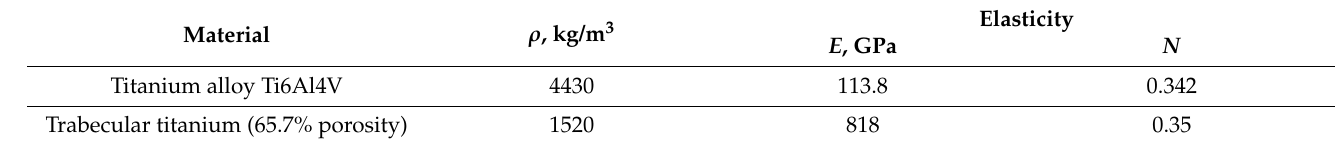
Table 1. Physical and mechanical properties of implant material.